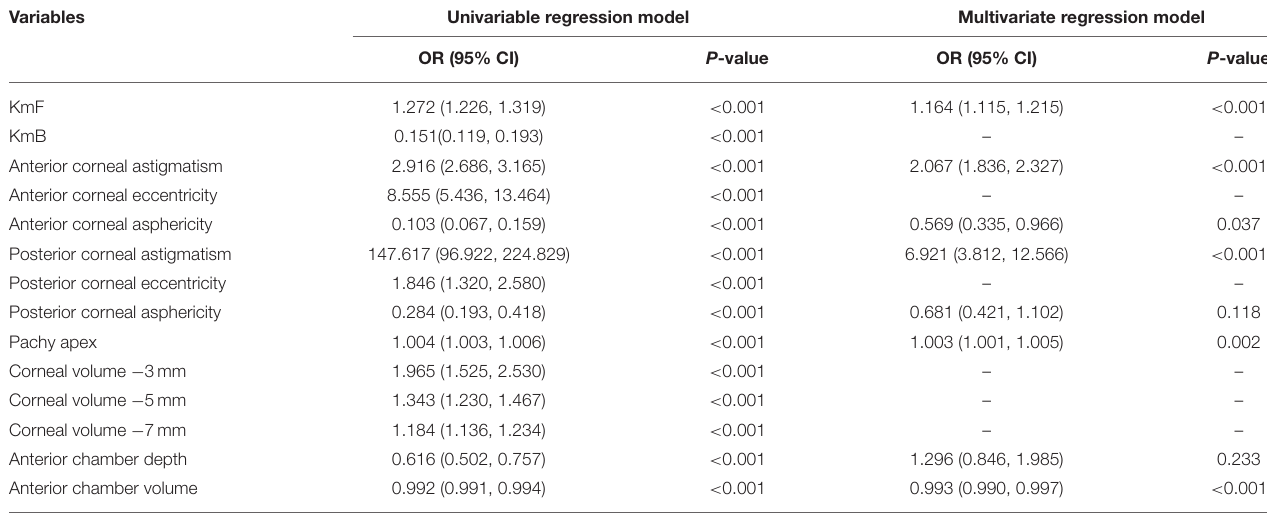
TABLE 3 | Logistic regression analyzing associated factors on ORA larger than 1.0 diopters.